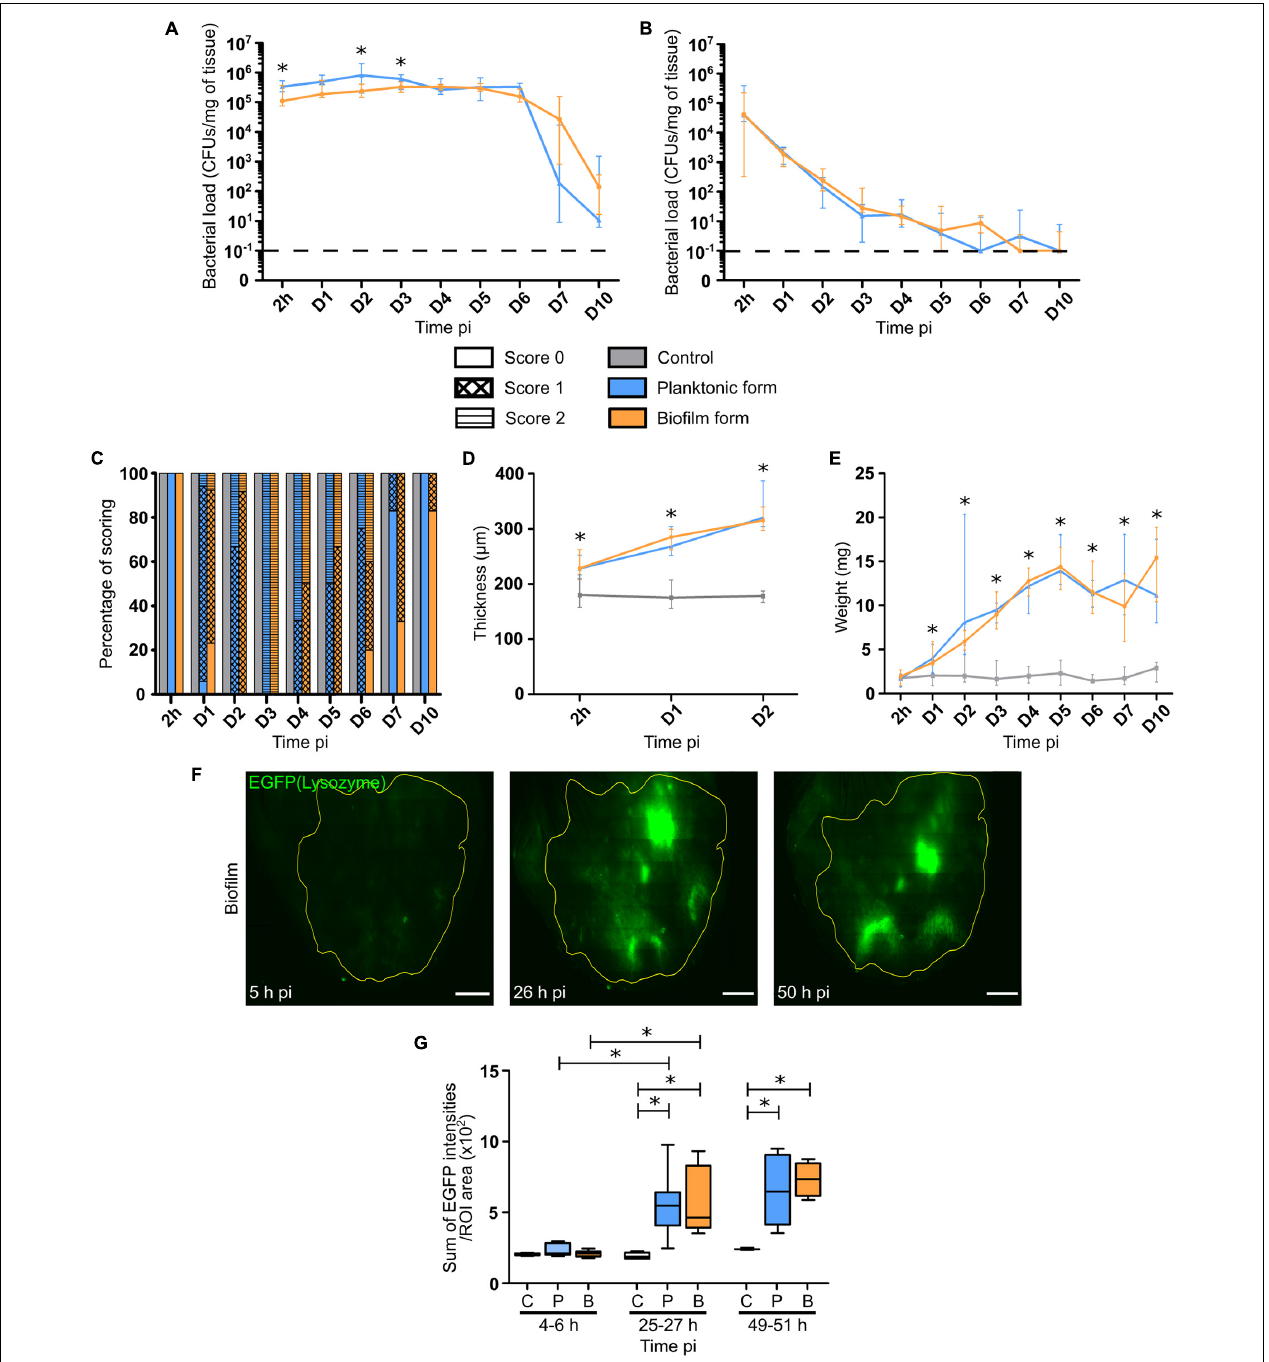
FIGURE 1 | Bacterial load and inflammatory responses in S. aureus infected tissue. (A,B) Bacterial load quantification, expressed in CFUs/mg of tissue, from 2 h pi to day 7 pi, and at day 10 pi in the ear pinnae (A) and dLNs (B) of WT C57BL/6J mice following micro-injection of PBS (C) or WT SH1000 planktonic (P) or biofilm (B) bacteria. Dotted line represents the limit of detection (median ± IQR, number of ear pinnae: N C = 8–10 ear pinnae, N P = 10–12 ear pinnae, N BF = 11–12 ear pinnae, from 3 different experiments, Mann-Whitney two-tailed test, ∗ p < 0.05). (C) Evaluation of ear pinnae inflammation from 2 h pi to day 7 pi, and at day 10 pi for the 3 groups of mice, by scoring based on erythema. Results expressed as percentage of each score (Number of mice: N C = 6–10 mice, N P = 4–17 mice, N BF = 5–13 mice, from 3 different experiments). (D) Ear pinna thickness measurements from 2 h pi to day 2 pi for the 3 groups of mice (median ± IQR, number of ear pinnae: N C = 4–7 ear pinnae, N P = 6–8 ear pinnae, N BF = 6–7 ear pinnae, from 3 different experiments, Mann-Whitney two-tailed test, ∗ p < 0.05). (E) dLN weight measurements from 2 h pi to day 7 pi, and at day 10 pi for the 3 groups of mice (median ± IQR, number of dLNs: N C = 8–10 dLNs, N P = 10–12 dLNs, N BF = 11– 12 dLNs, from 3 different experiments, Mann-Whitney two-tailed test, ∗ p < 0.05). (F) Reconstituted confocal images of LysM-EGFP transgenic mouse ear pinna tissue